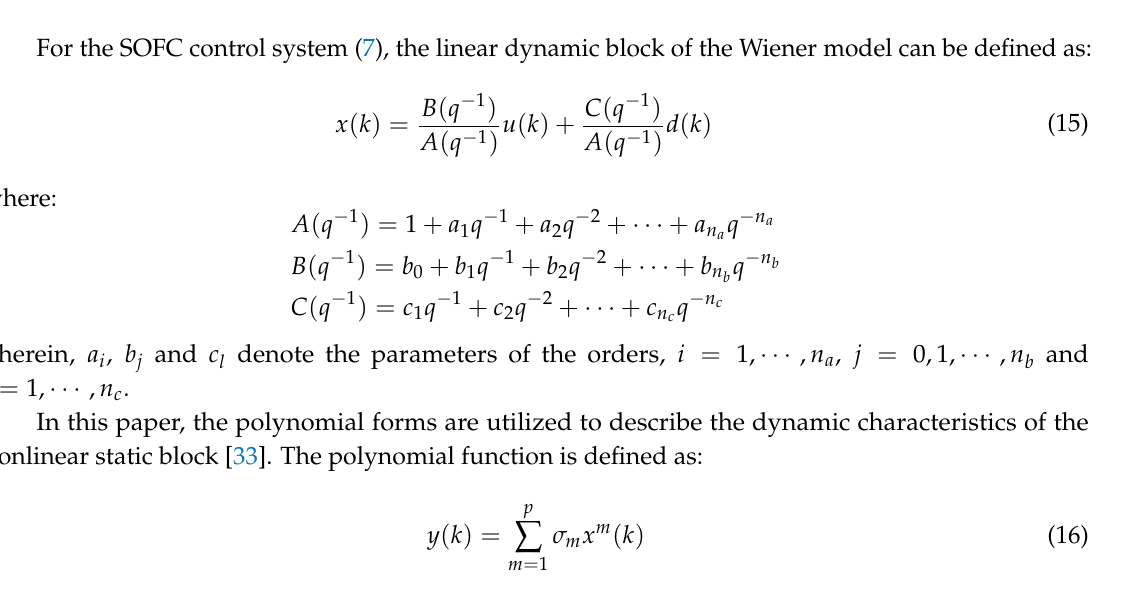
Figure 4. The structure of the Wiener